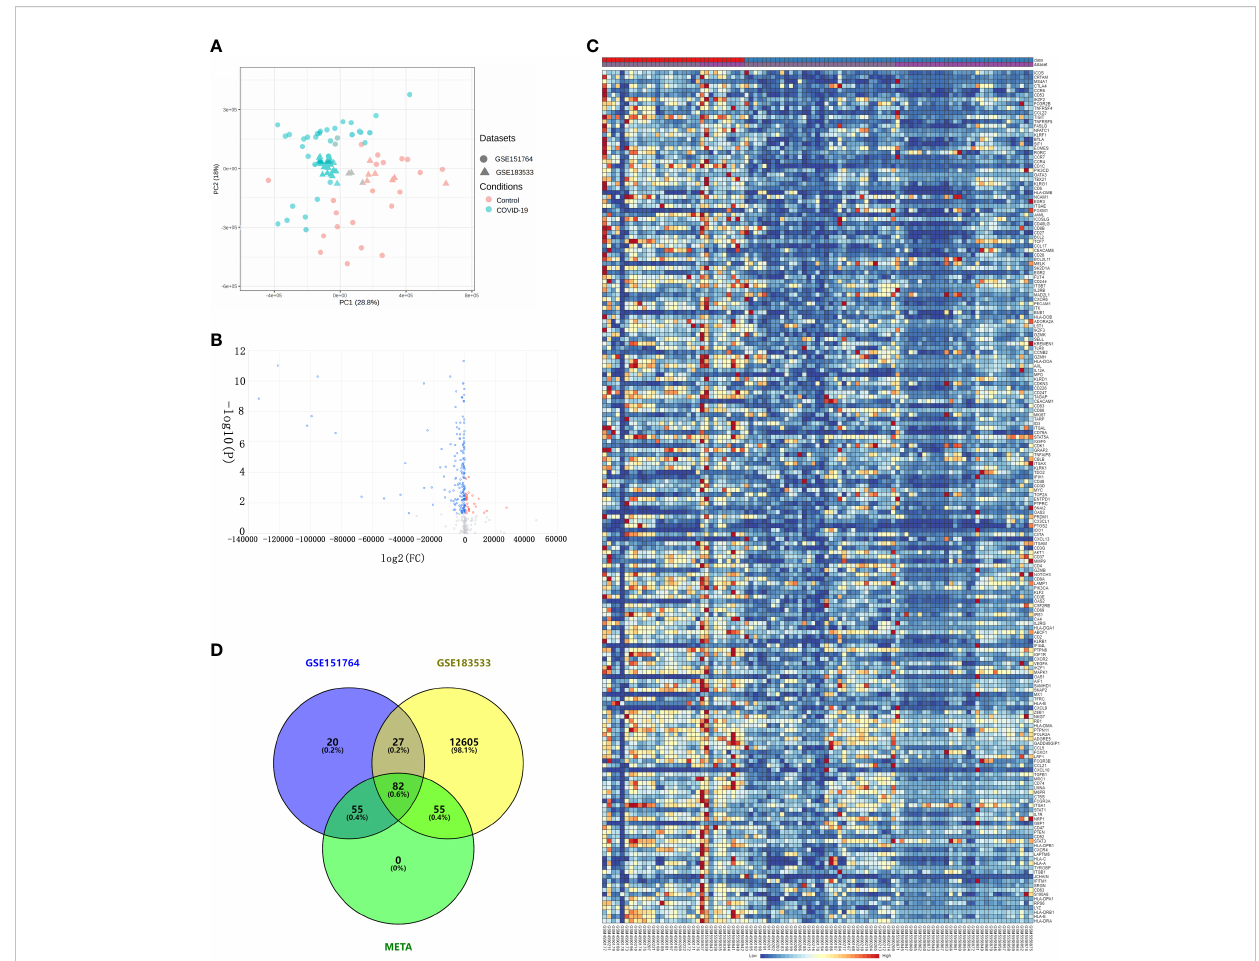
FIGURE 2 Differential expression analysis via comprehensive transcriptome meta-analysis using the GSE151764 and GSE183533 datasets. (A) Bidimensional principal component analysis for COVID-19 and control samples; red, control group; blue, COVID-19. (B) Volcano plot showing the results of differential expression analysis between control and COVID-19 groups. (C) Heatmaps of DEGs co-expressed between the COVID-19 and control groups. Legend at the top right indicates log-fold change in gene expression level. Horizontal axis, each sample; vertical axis, each gene. Blue and red colors represent low and high expression values, respectively. (D) Venn diagram of